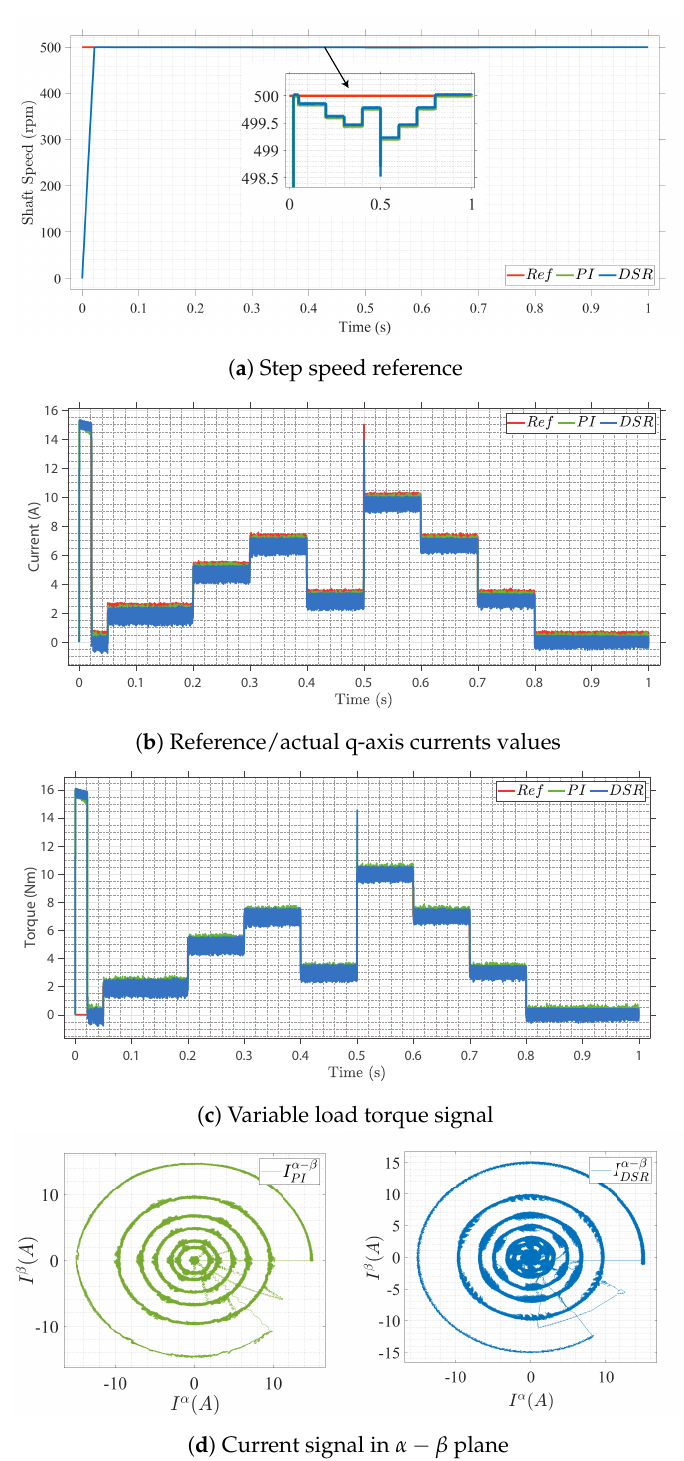
Figure 6. Closed-loop control performance under load